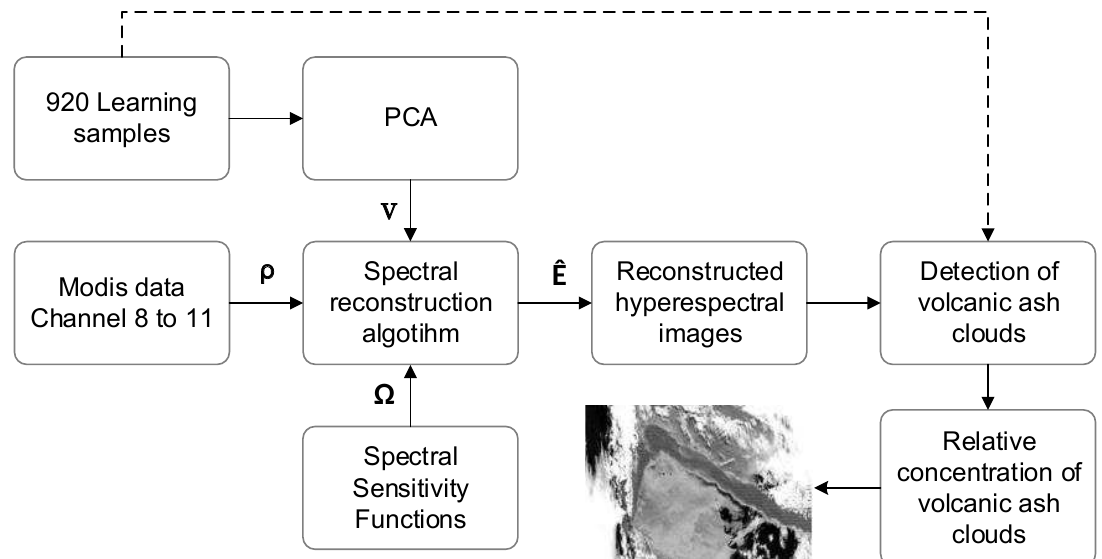
Figure 1. Volcanic ash monitoring methodology, based on spectral retrieval and MODIS satellite images.